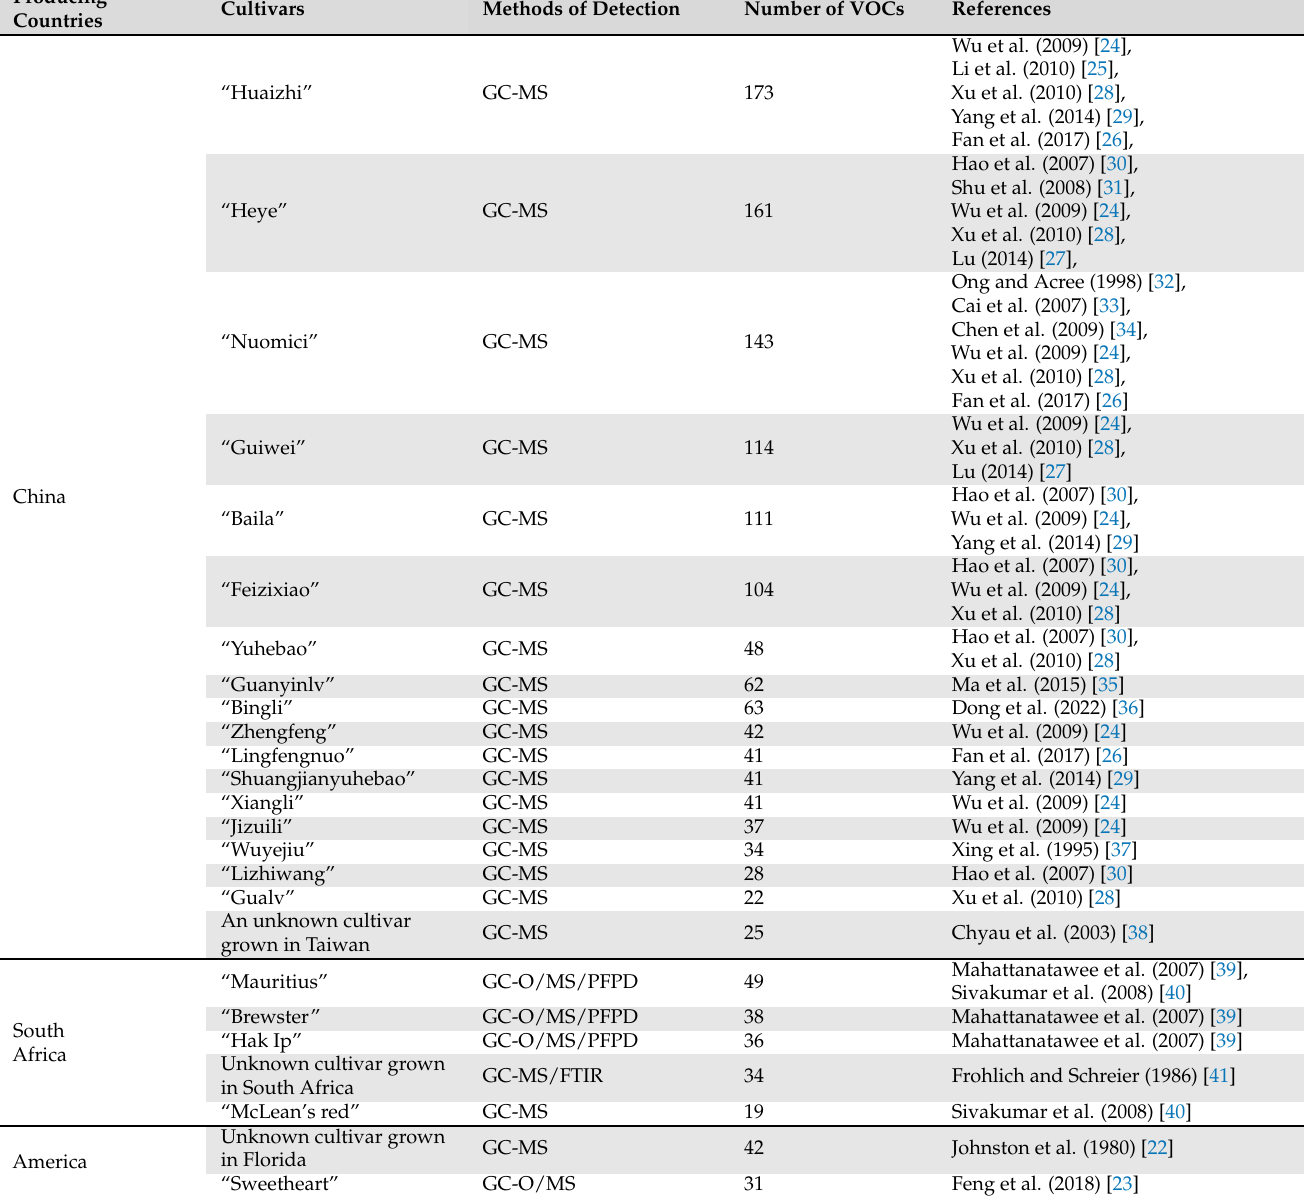
Table 1. List of the number of VOCs identified with different methods in different